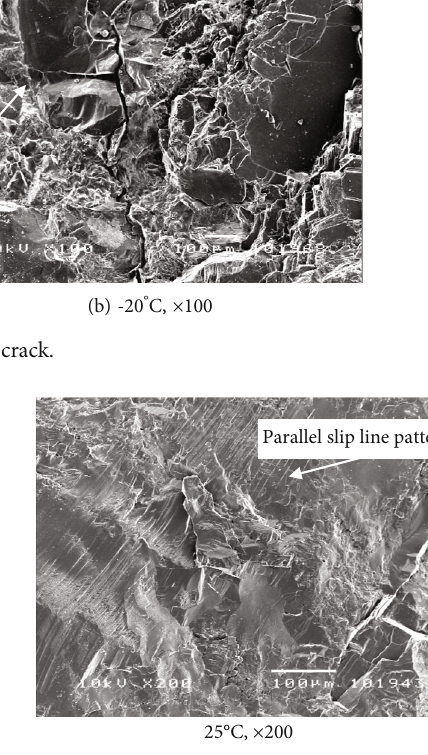
Figure 14: Lamellar tearing fracture.